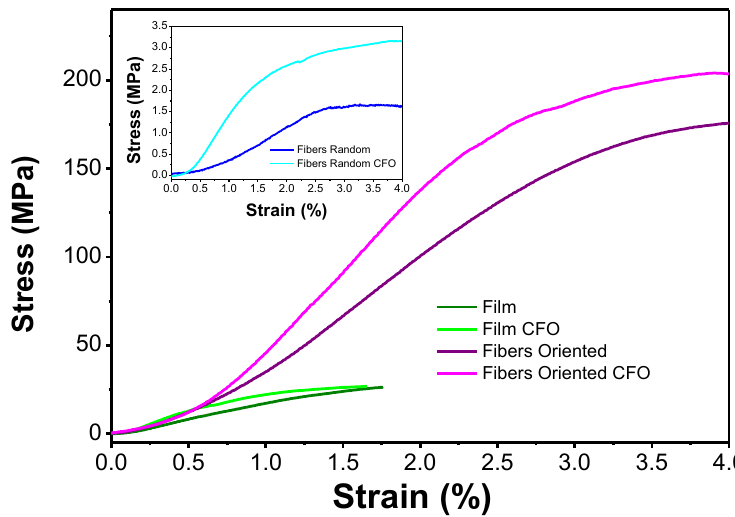
Figure 6. Mechanical stress-strain behavior of the different PHBV samples with and without CFO. Table 3. Young’s modulus of the different PHBV samples. Values shown as mean ± SD. Morphologies